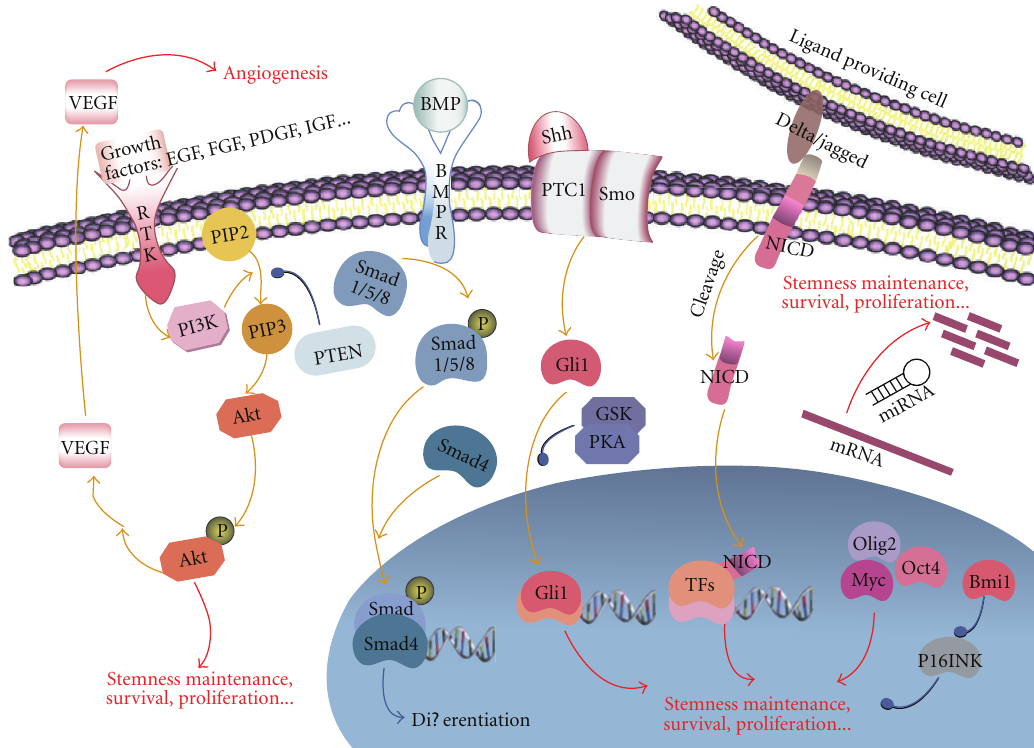
Figure 2: Complex signal pathways and cellular factors regulate GSC. GSC are controlled at multiple levels by complicated regulatory networks. Signals initiated by receptor tyrosine kinases (RTK), bone morphogenetic protein receptors (BMPR), Hedgehog, and Notch result in complicated intracellular events to help balance self-renewal and di ff erentiation of GSC as well as the promotion of cell survival and proliferation. Intracellular regulators including transcriptional factors (Olig2, Myc, Oct4, etc.), epigenetic modifiers (Bmi1), and microRNAs are also highly potent of maintaining GSC populations due to their ability to regulate massive downstream targets simultaneously (from [74] with